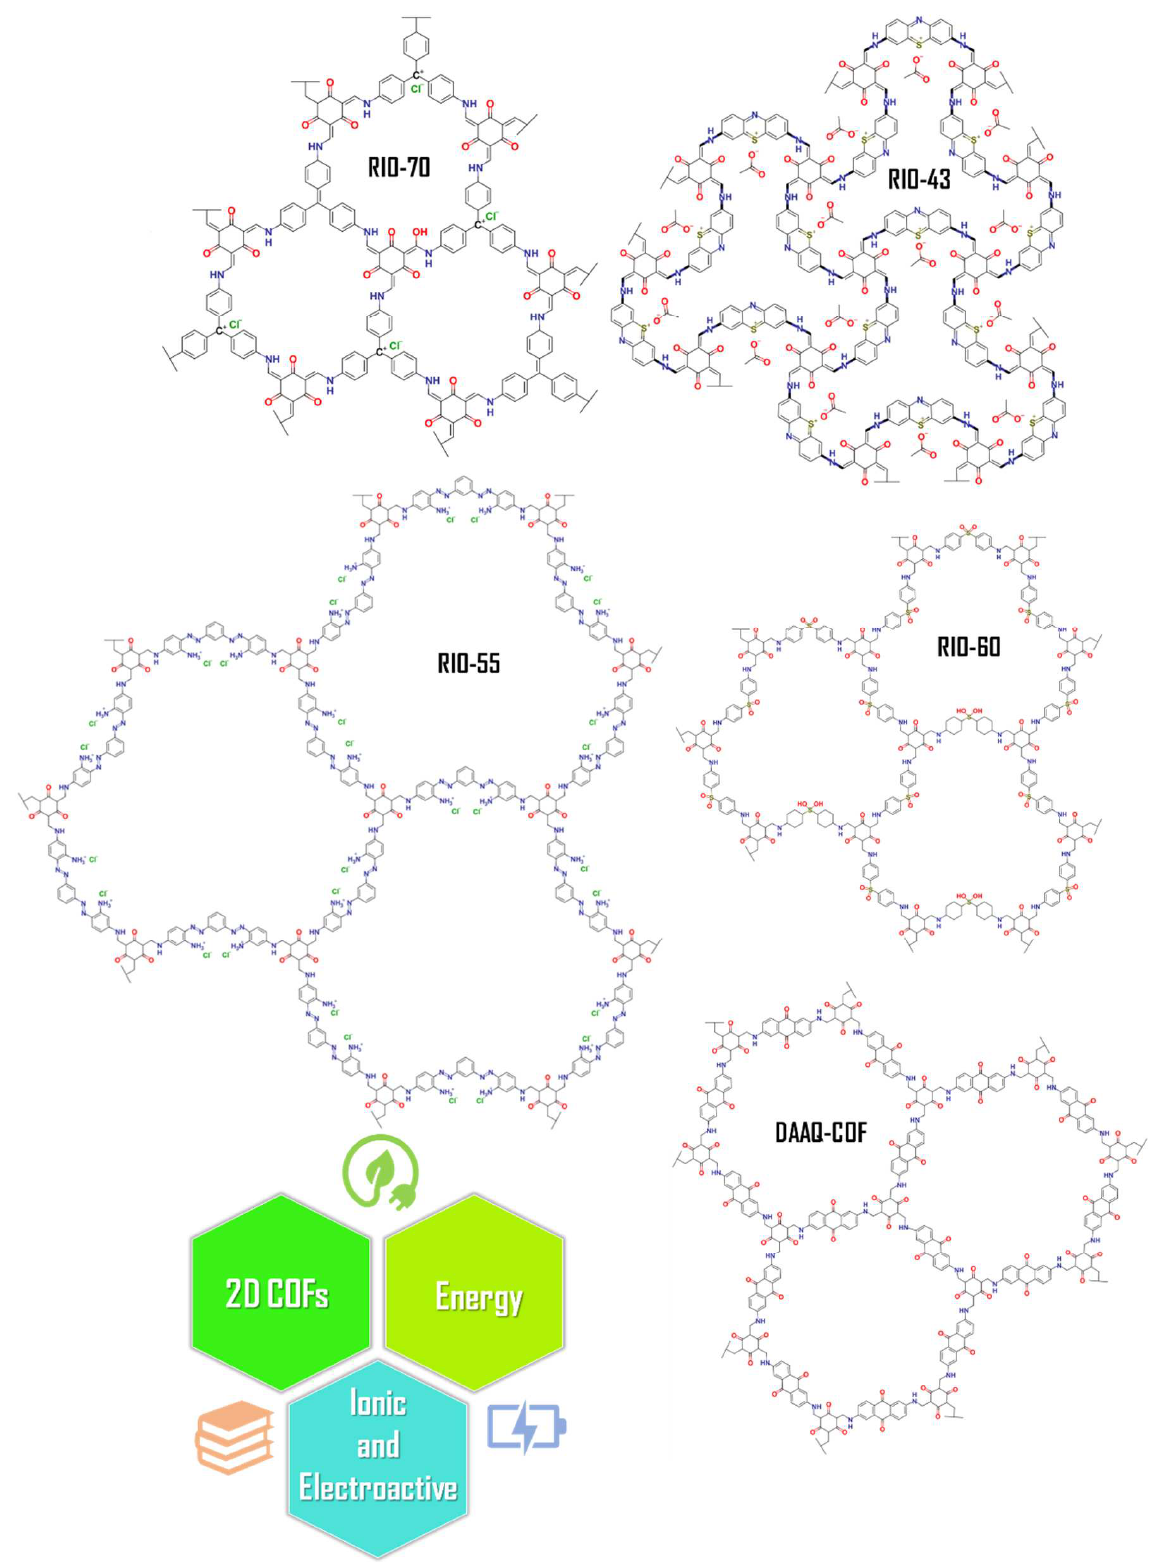
Figure 2. Chemical structures of selected 2D COFs with different pore sizes. The ionic and electroactive porous materials could be applied in the energy field, such as in solar cells, working on different interfaces.